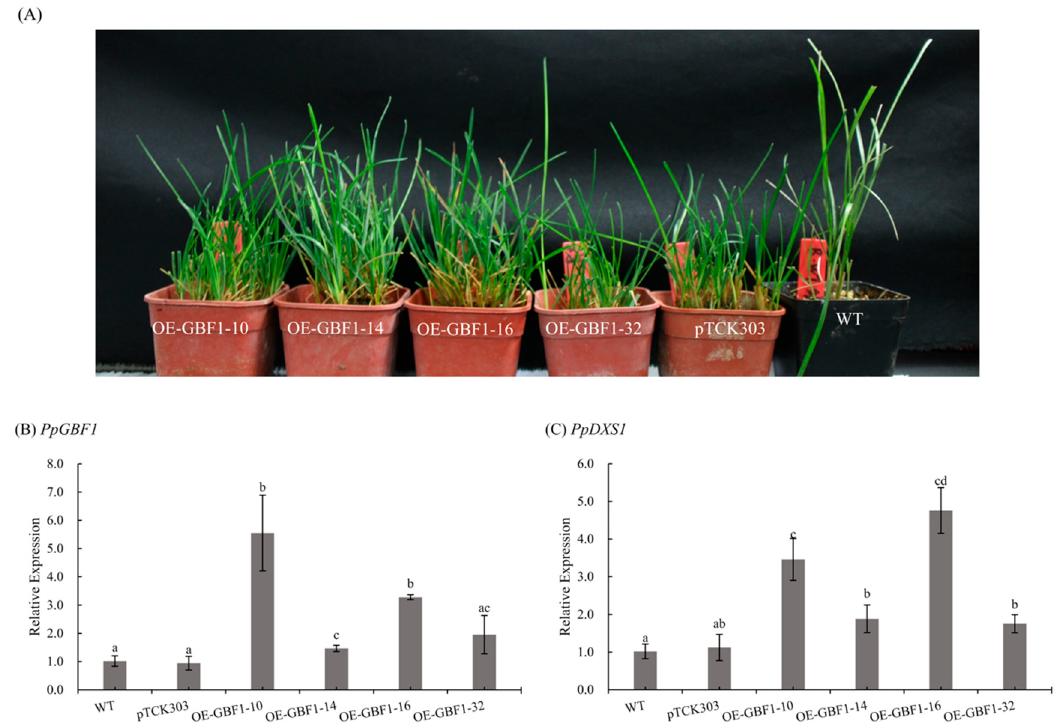
Figure 5. Characterization of PpGBF1 transgenic plants. ( A ) Pictures of OE- PpGBF1 transgenic lines. From left to right, these are OE- GBF1 -10, OE- GBF1 -14, OE- GBF1 -16, OE- GBF1 -32, pTCK303 control, and wild type; ( B ) relative expression of PpGBF1 gene in transgenic lines; ( C ) relative expression of PpDXS1 gene in transformed OE- GBF1 plants. The Actin is the reference gene, and the control plant is transformed pTCK303 empty vector line. All qRT-PCR reactions were performed from triplicate biological samples. The 2 − ∆∆ C t method was used to calculate the fold expression relative to the control. Mean of three replicates ± standard error is shown. Different letters above the bars indicate significant difference ( p < 0.05).